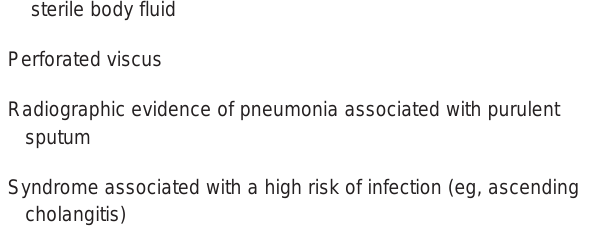
TABLE 1 Infection criteria as defined in the Protein C Worldwide Evaluation in Severe Sepsis trial Presence of abnormally elevated white blood cell count in normally sterile body fluid